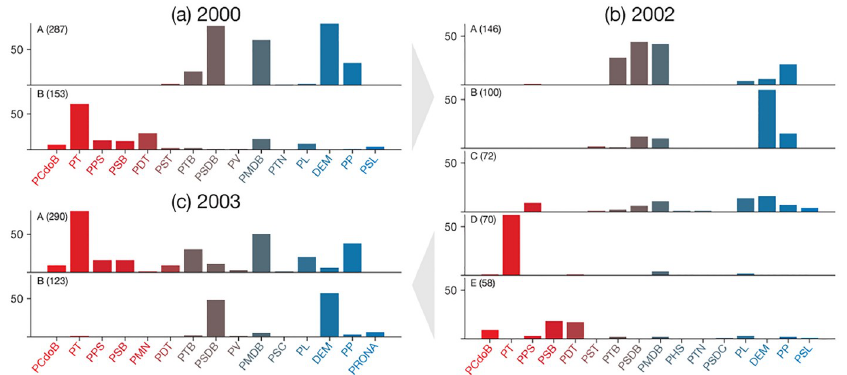
Fig 12. Distribution of parties among communities for Mr. Silva’s first presidential term and preceding elections. The charts correspond to the communities obtained for the indicated year. Each bar chart indicate a community with the number of deputies indicated in parenthesis. Only communities with at least 15 deputies are considered. Parties were ordered from left to right (and colored from red to blue) according to their political positions [39]. The names of parties and abbreviations are historical and were not updated to the currently adopted names.